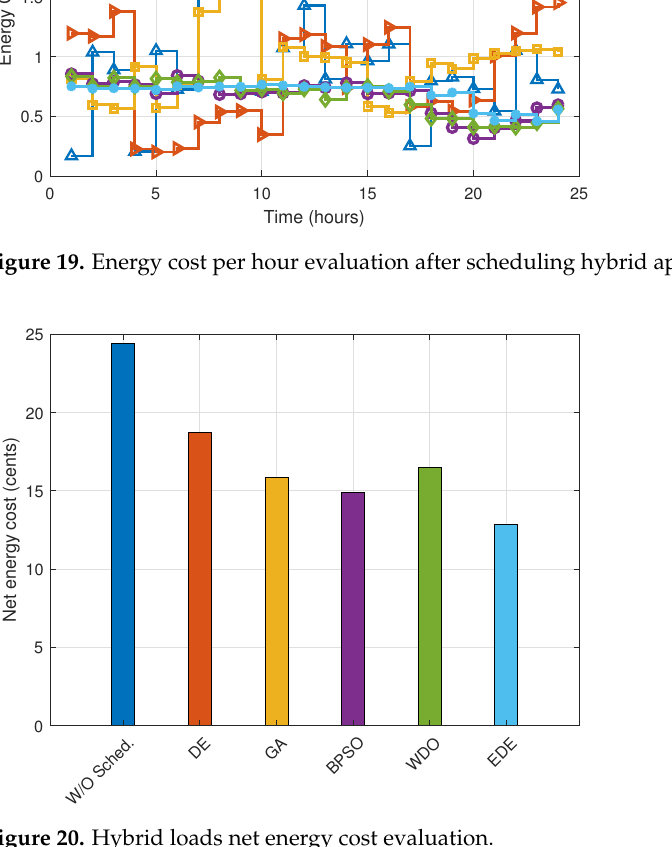
Figure 20. Hybrid loads net energy cost evaluation. Table 10. Numerical results of hybrid load net energy